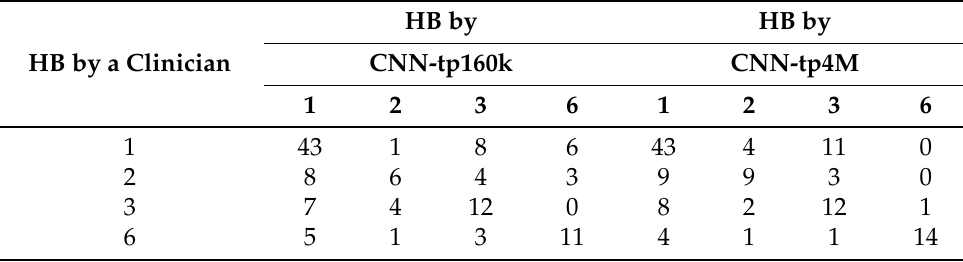
Table 4. Confusion matrix with numbers of (mis) classified cases by CNN neural network structures on a test set (tp marks the number of trainable